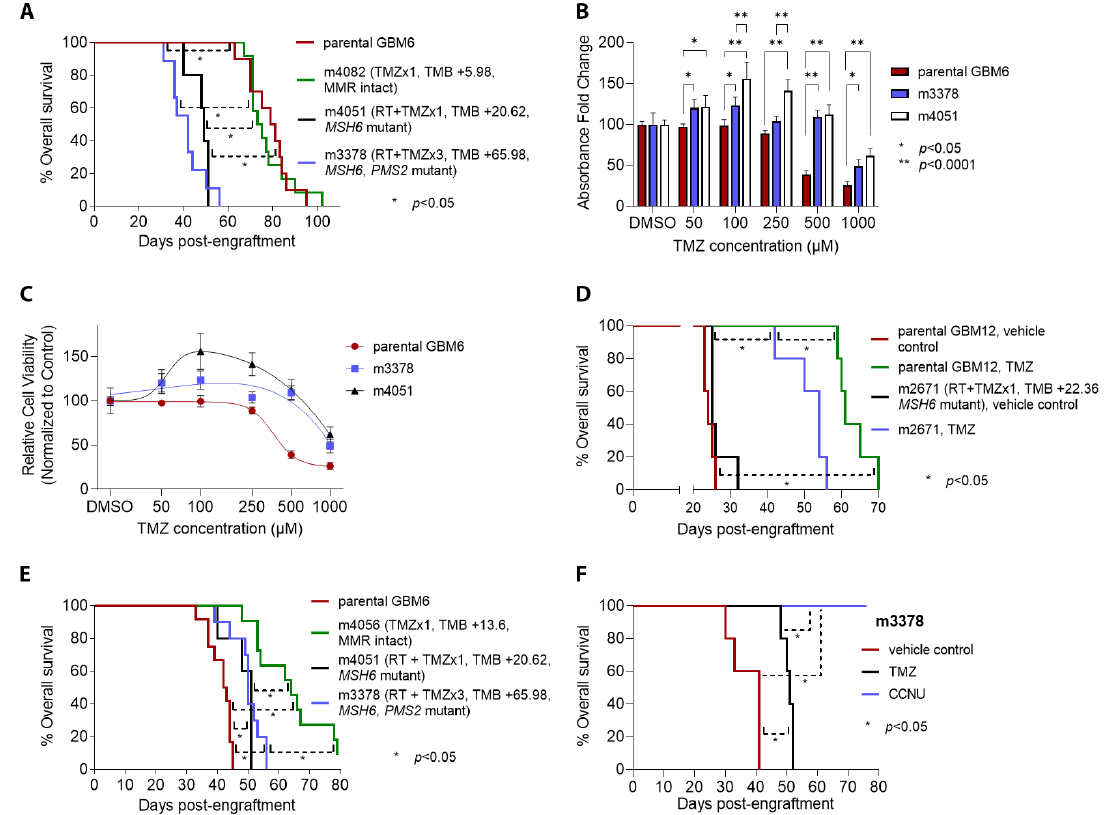
Figure 5. Sensitivity to chemotherapy and radiation in derivative PDX. ( A ) Survival analysis after a single dose of TMZ for mice ( n = 10 per group) engrafted with parental GBM6 versus derivatives m4082 (post-TMZ ×1, MMR genes intact, low TMB gain), m4051 (post-RT and TMZ ×1, acquired MSH6 mutation, higher TMB gain), and m3378 (post-RT and TMZ ×3, acquired MSH6 and PMS2 mutations, high TMB gain). ( B ) In vitro TMZ sensitivity assays with MTT for parental GBM6 versus derivatives m3378 and m4051 across multiple concentrations of TMZ, with DMSO as vehicle control. ( C ) Best fit dose–response curves to TMZ for parental GBM6 versus m3378 and m4051. ( D ) Survival analysis after a single dose of TMZ (compared to vehicle control) for mice ( n = 5 per group) engrafted with parental GBM12 versus derivative m2671 (post-RT and TMZ ×1, with acquired MSH6 mutation). ( E ) Survival analysis after a cycle of RT for mice engrafted with parental GBM6 ( n = 12), MMR-intact derivative m4056 ( n = 10), and MMR-deficient derivatives m4051 ( n = 5) and m3378 ( n = 10). ( F ) Survival analysis for mice ( n = 5 per group) engrafted with GBM6 derivative m3378 and treated with a single cycle of TMZ versus a single cycle of CCNU (lomustine), compared to vehicle control (For ( A , B , D – F ), * p < 0.05, ** p < 0.0001).